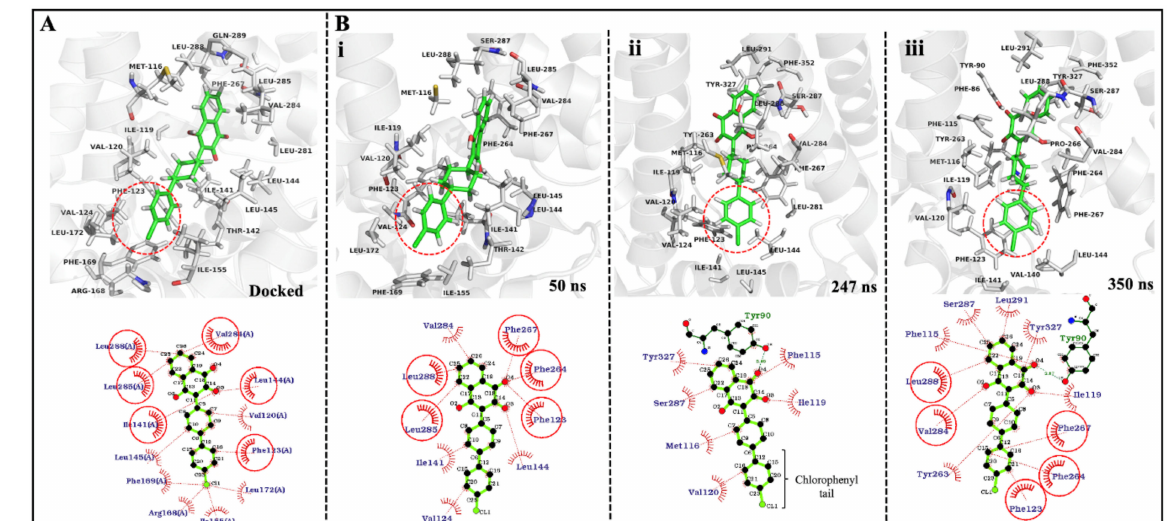
Figure 5. 3D and 2D ligand interactions of ATQ drug in docked pose and across different time steps during 350 ns simulations. ( A ) ATQ docked pose and its interaction within 5 Å radius around ATQ drug in the PfCytb-ISP Qo active site pocket; ATQ in green while active site residues in gray. ( B ) ATQ-bound protein and ATQ interactions during three time steps of the MD simulation. The 3D figures show Qo active site pocket of PfCytb-ISP protein in gray while ATQ drug is shown in green as stick representation in both 3D and 2D representation. Red dotted circle represents the chlorophenyl tail of the ATQ drug.